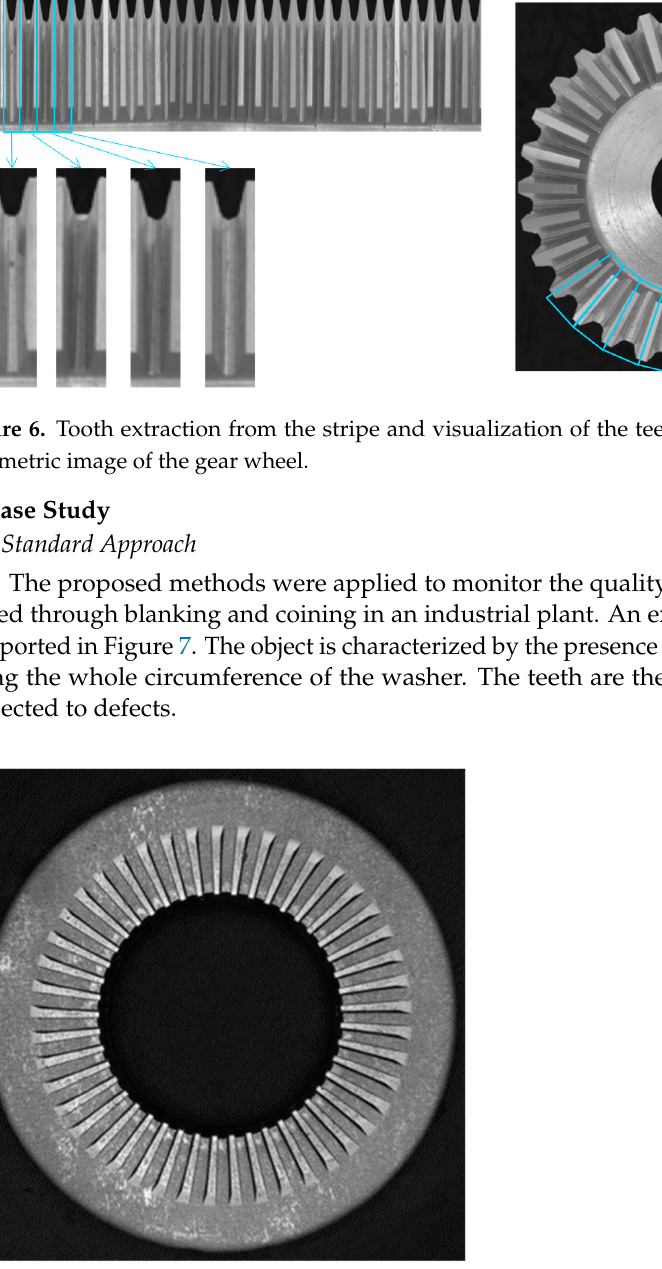
Figure 8. Procedure for the extraction of the stripe from the cartesian picture, and the construction of the pseudo signal from the stripe applied on the knurled washer. The Fourier transform 𝛤(cid:4666)𝑘(cid:4667) of the pseudo-signal is shown in Figure 9, and the num- ber of repeated elements in the CSC is N = 45 since the washer has 45 coined teeth. The most relevant harmonics are the multiple of 45.